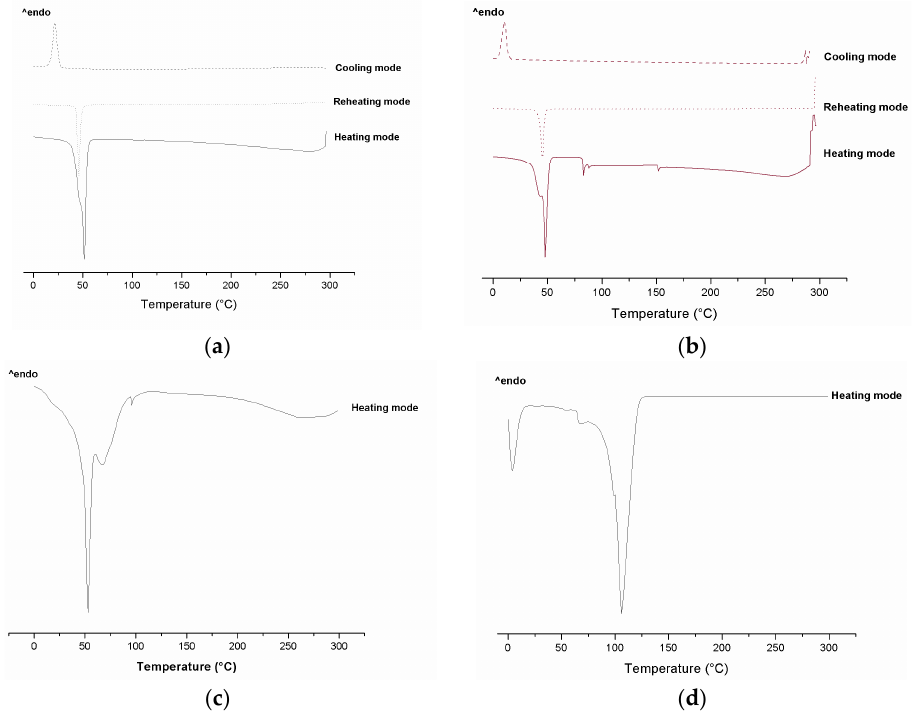
Figure 4. DSC scans of SLNs: ( a ) F1 and ( b ) F1.RES (heating from − 50 to 270 °C, subsequent cooling from 270 to − 50 °C, and reheating from − 50 to 270 °C, at a rate of 10 °C·min − 1 ); ( c ) F2 and ( d ) F2.RES (heating from − 50 to 270 °C). All formulations were tested at all 3 temperature cycles; however, only the cycles with thermal events are shown. Formulations F2 and F2.RES presented thermal events only in the heating mode.